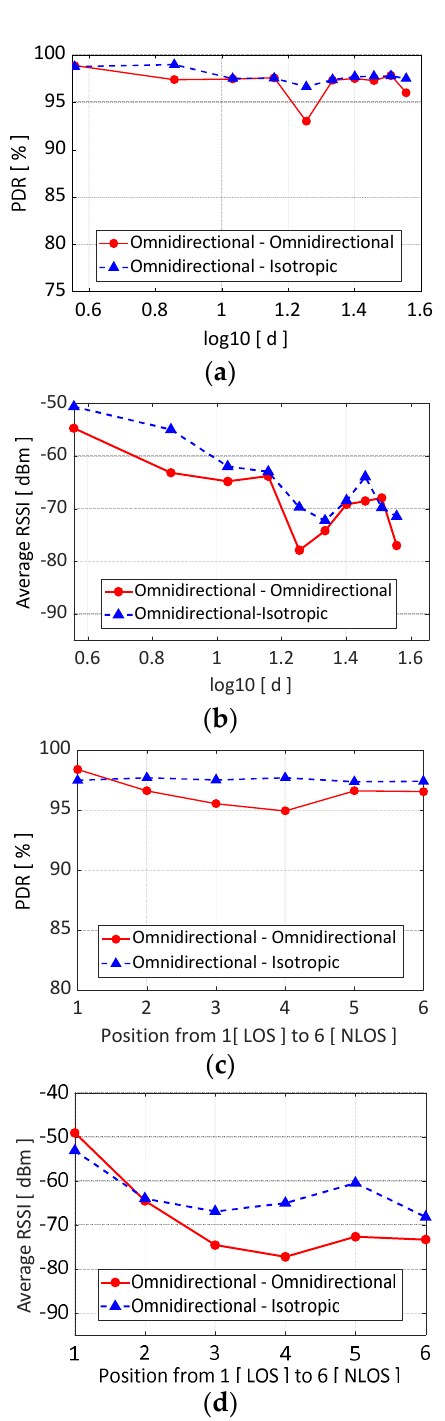
Figure 13. Measured PDR and RSSI. ( a ) PDR under LOS, ( b ) RSSI under LOS, ( c ) PDR under NLOS, and ( d ) RSSI under NLOS.